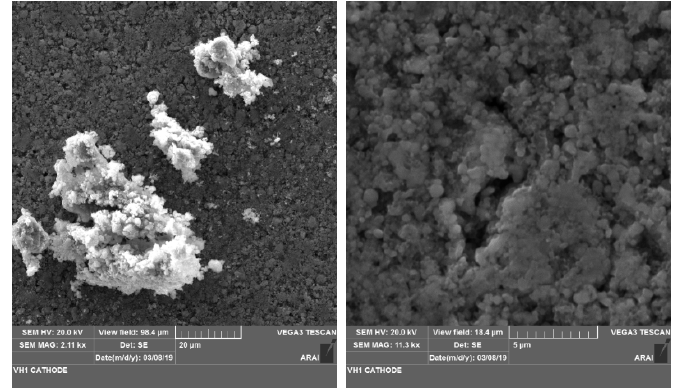
Figure 12. Cathode of the cell after vibration testing.